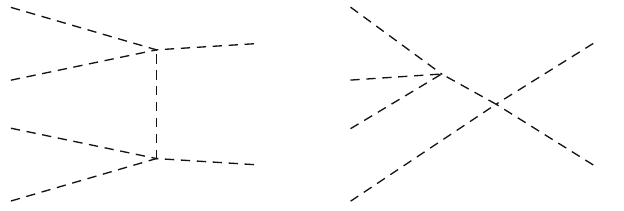
Fig. 2 Examples of Feynman diagrams for the 4 → 2 scalar self- annihilation process